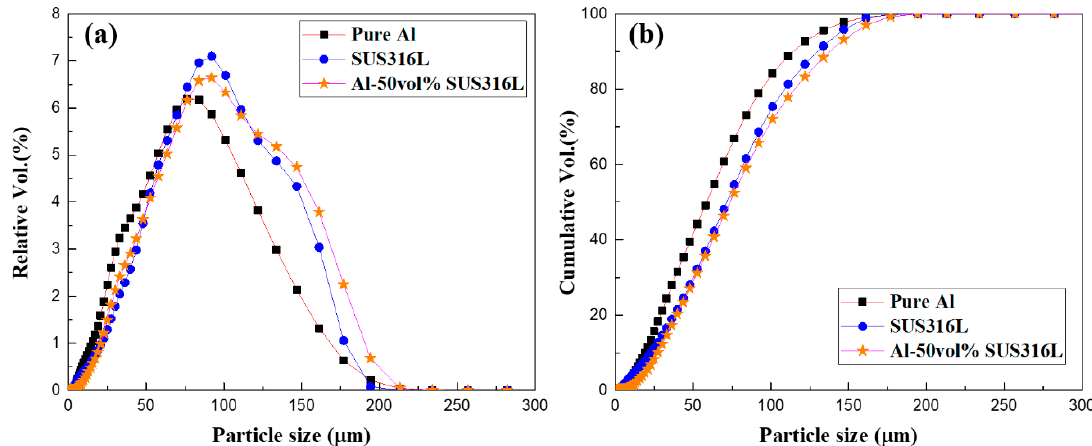
Figure 2. ( a ) Relative and ( b ) cumulative particle size analyses of pure Al, SUS316L, and Al-50 vol.% SUS316L powders.